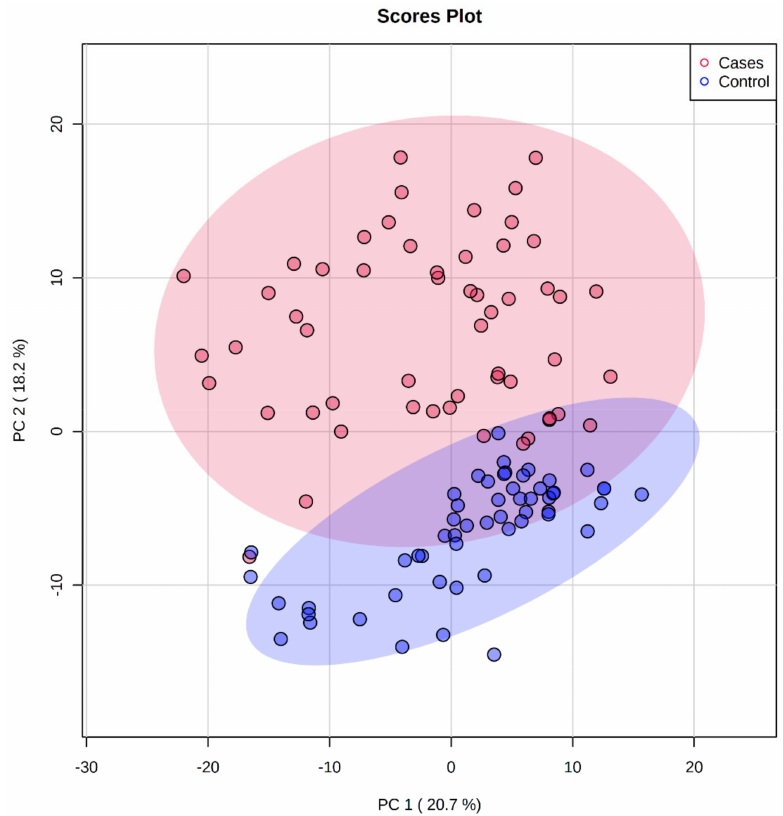
Figure 1. PCA 2D scores plot showing the first two principal components depicting the variance (shown in parenthesis) among the 55 samples.